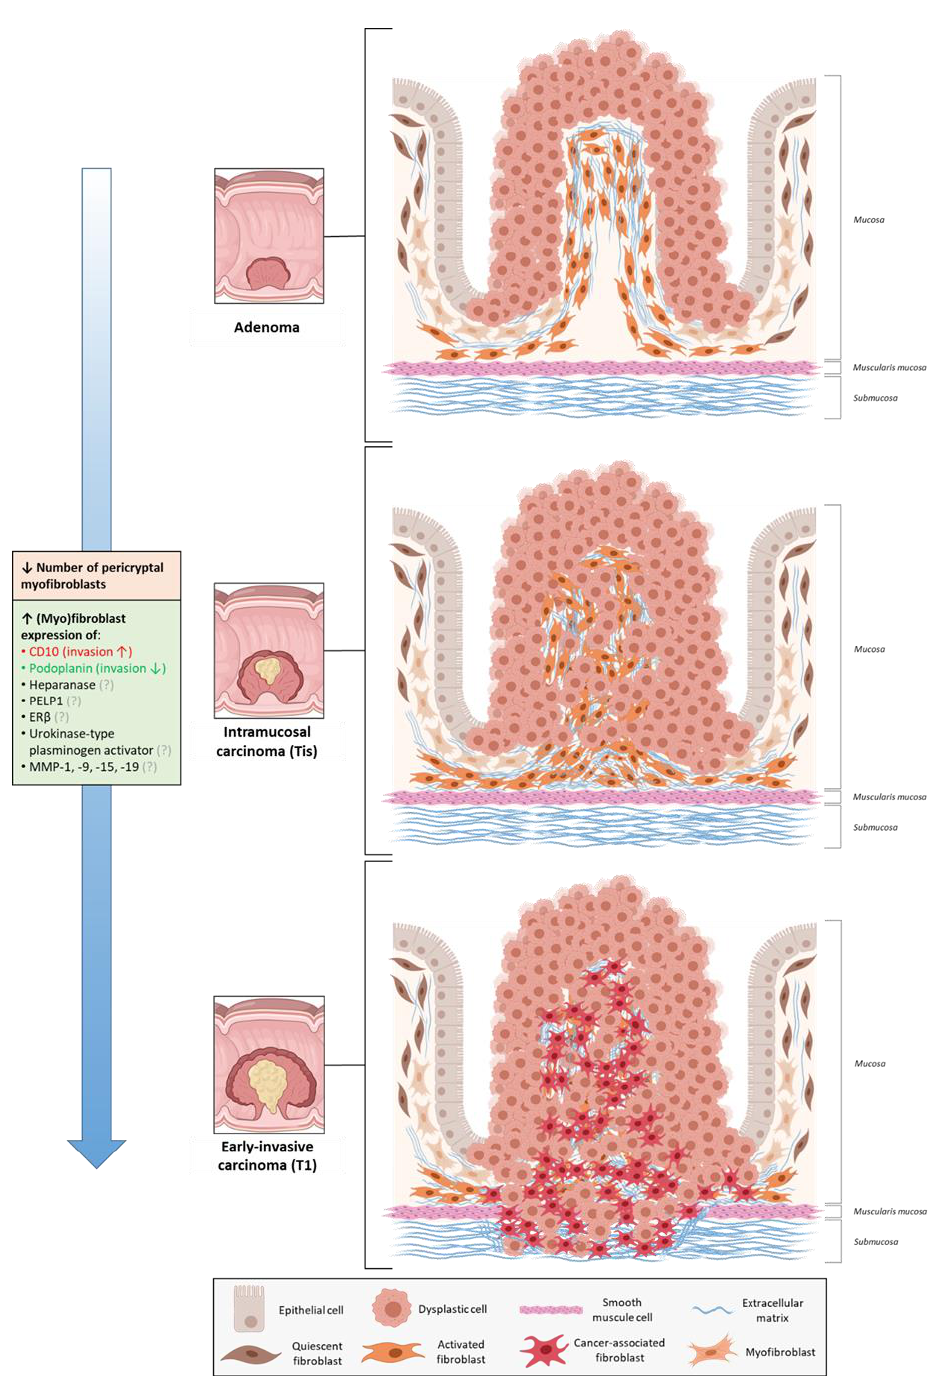
Figure 2. Fibroblasts during malignant progression of intestinal adenomas. CD, cluster of differen- tiation; PELP1, proline-glutamic acid-leukine rich protein 1 (PELP1); ERβ, estrogen receptor beta; MMP, matrix metalloproteinase. (Created with BioRender.com).